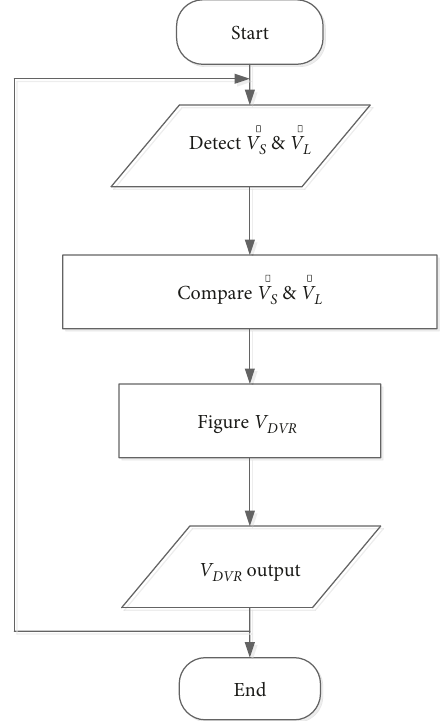
Figure 5: Flow chart of traditional strategy of DVR system.